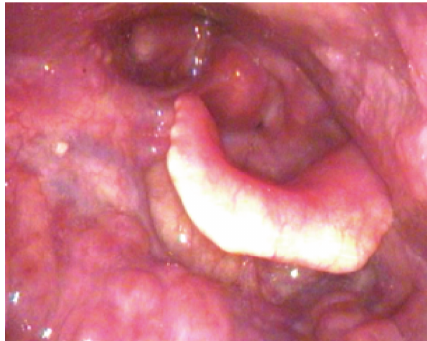
Figure 4: Laryngoscopy was performed three months posttreat- ment. There was no evidence of residual tumor.